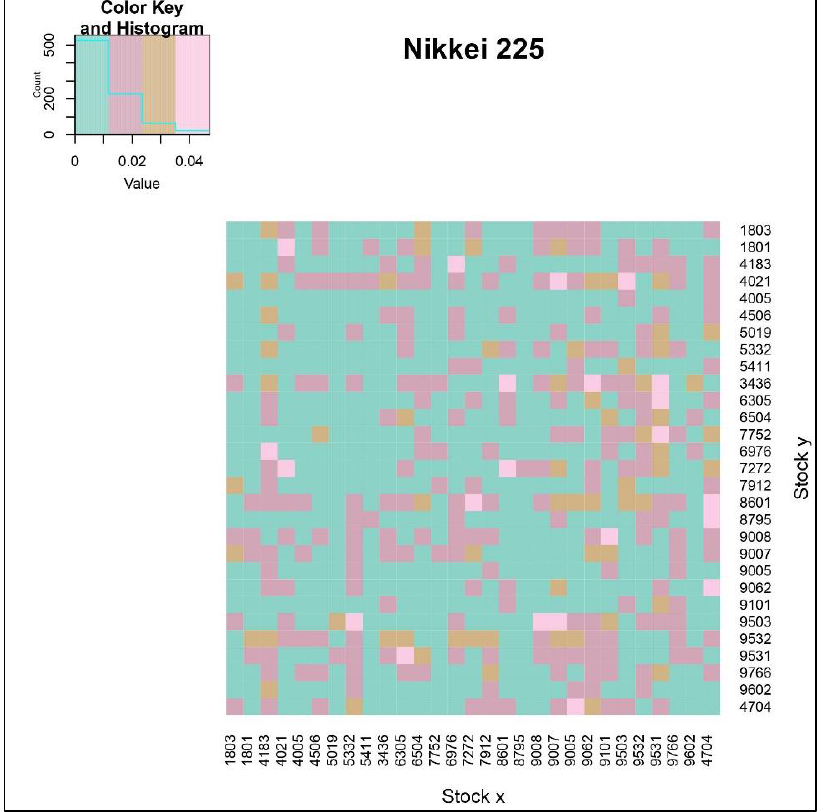
Figure 14. The information flow (effective transfer entropy) from stock y to stock x, for the top companies (by market capitalization) in the Nikkei market, after the COVID-19